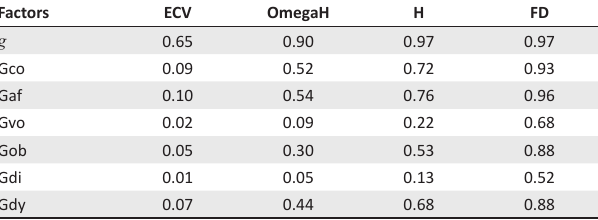
TABLE 5: Bifactor statistical indices for model of goal commitment.